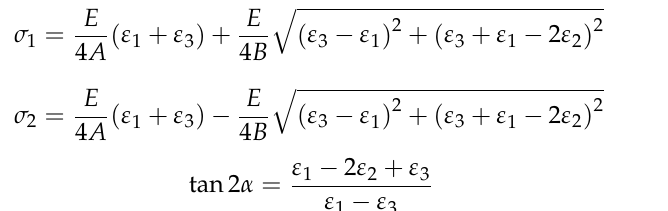
Table 2. The welding process parameters.